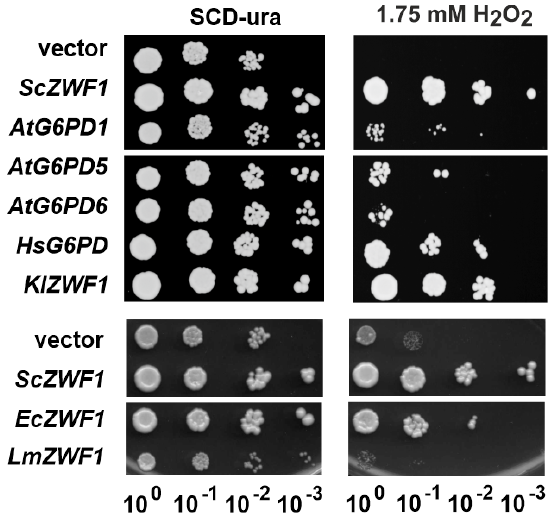
Figure 2. Drop dilution assays of a yeast zwf1 deletion strain expressing heterologous G6PD genes. Logarithmically growing cultures of strain HOD269-1C ( zwf1::kanMX ) carrying the genes indicated on a CEN / ARS vector were diluted in fresh selective medium to an OD600 = 0.1 and subjected to ten-fold serial dilutions as indicated below.A quantity of 3 µ L of each dilution was dropped onto the plates indicated and growth was documented after 3 days incubation at 30 ◦